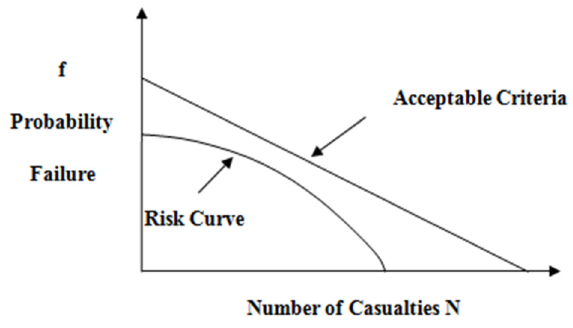
Figure 4. f-N curve.